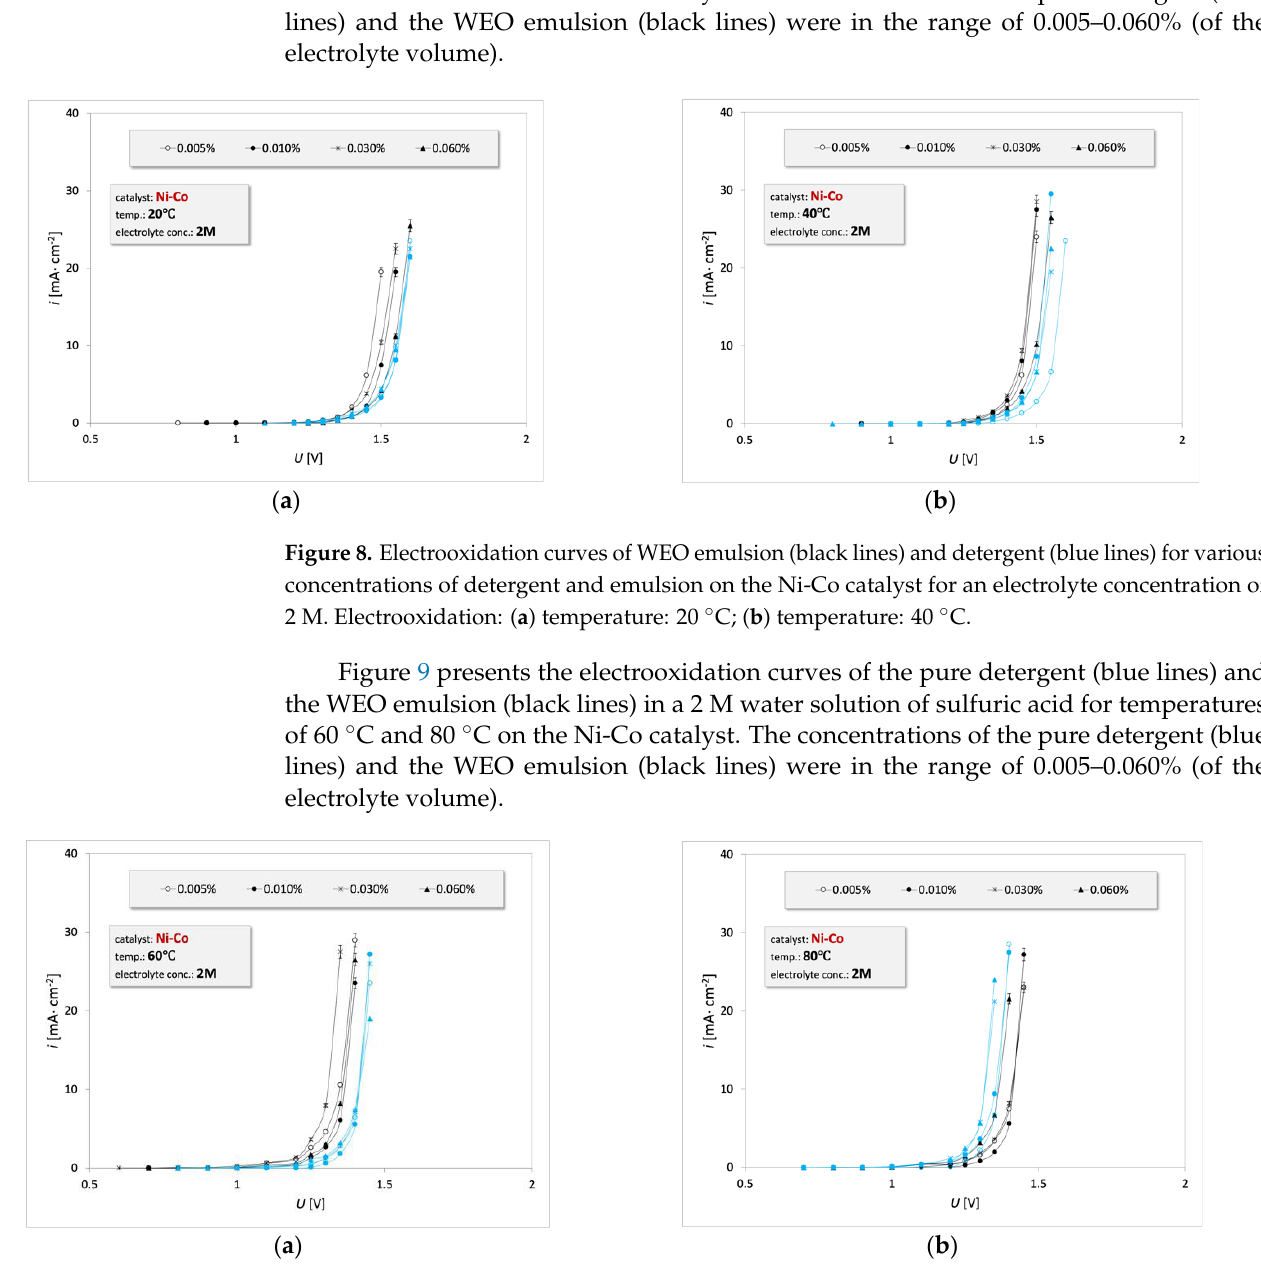
Figure 7. Electrooxidation curves of WEO emulsion (black lines) and detergent (blue lines) for var- ious concentrations of detergent and emulsion on the Ni-Co catalyst for an electrolyte concentration of 0.5 M. Electrooxidation: ( a ) temperature: 60 °C; ( b ) temperature: 80 °C.